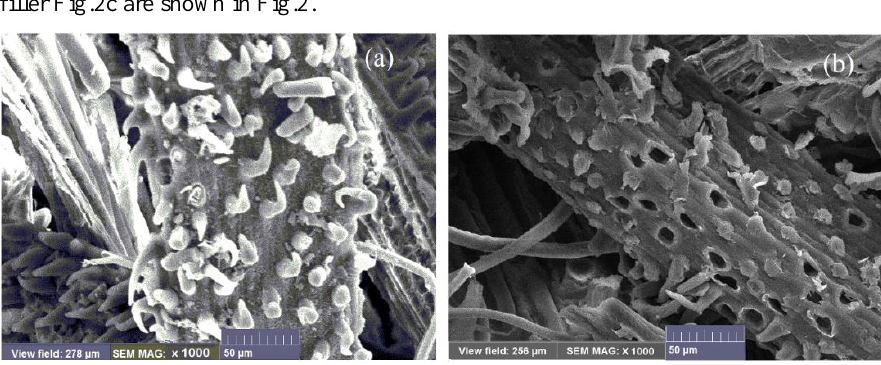
Fig. 1. SEM images of the Alfa (a) before treatment (b) after